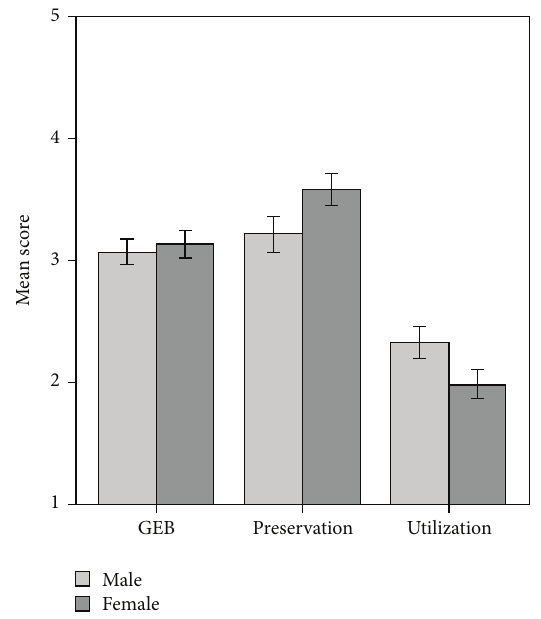
Figure 1: Gender differences are only observable for the 2-MEV domains; 𝑁 = 190 ; error bars show 95% CI.